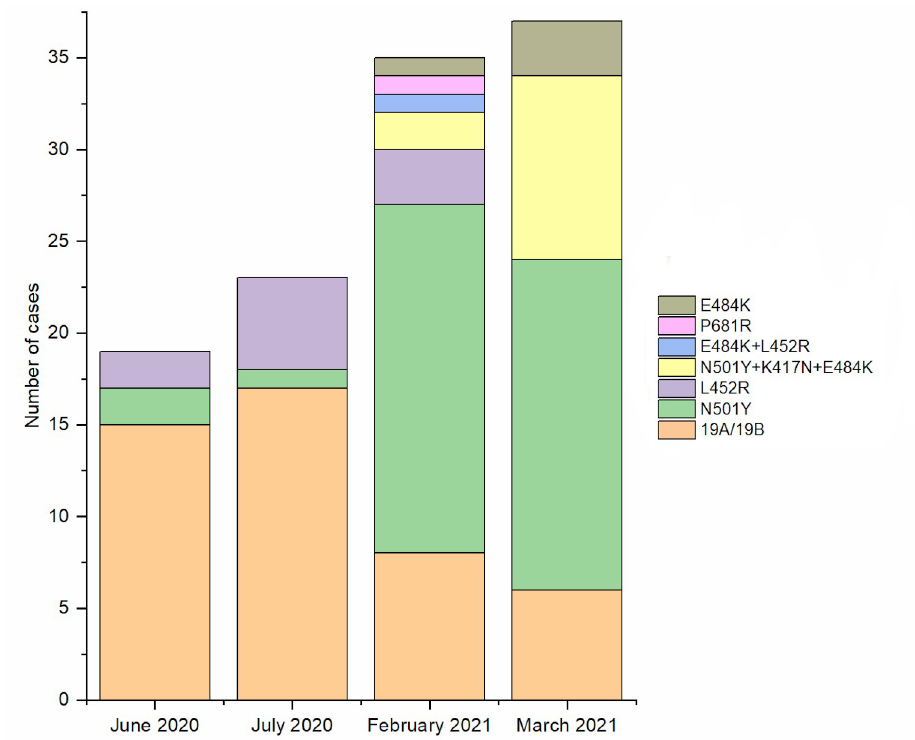
Fig 2. The distribution of SARS-CoV-2 S protein mutations detected in samples collected during four different periods between 2020 and 2021. https://doi.org/10.1371/journal.pone.0274961.g002 The viral load in nasopharyngeal swabs from patients testing positive for the L452R muta- tion was significantly higher compared to strain 19A / 19B ( p = 0.02), and mutations N501Y +K417N+E484K ( p = 0.008). On the other hand, the viral loads in stools were significantly